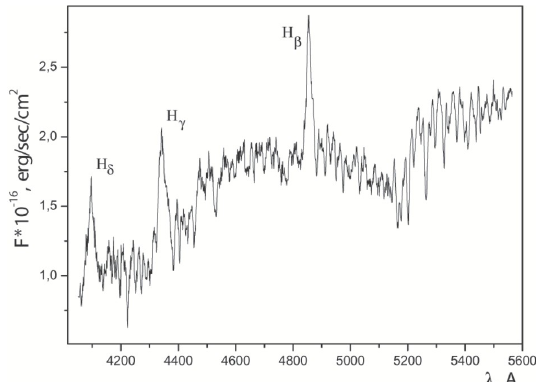
Figure 7: The spectrum of HS 0218+3229 on Novem- ber 5,